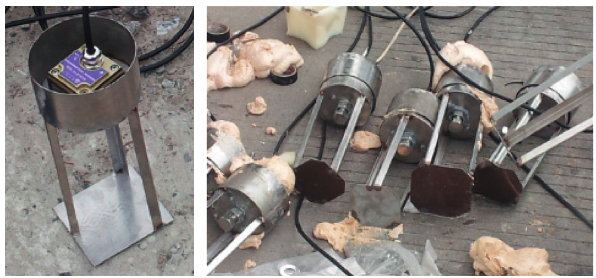
Figure 7: Accelerometer device in the ground.